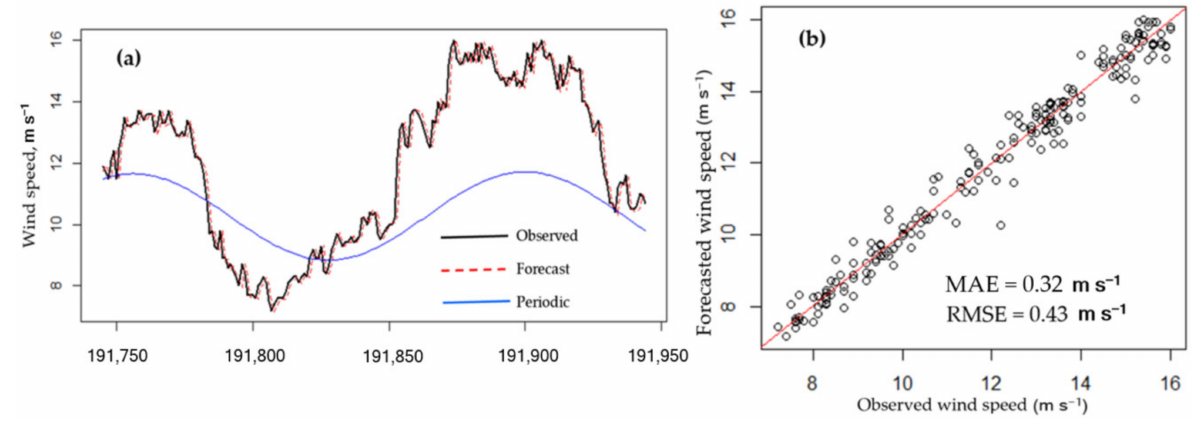
Figure 10. ( a ) 1-step lead time wind speed forecast using the time series model. The beginning time instance is 23 October 2019 13:20:00 local time. A unit of the x -axis equals 10 min. ( b ) Comparison of the observed and forecasted wind